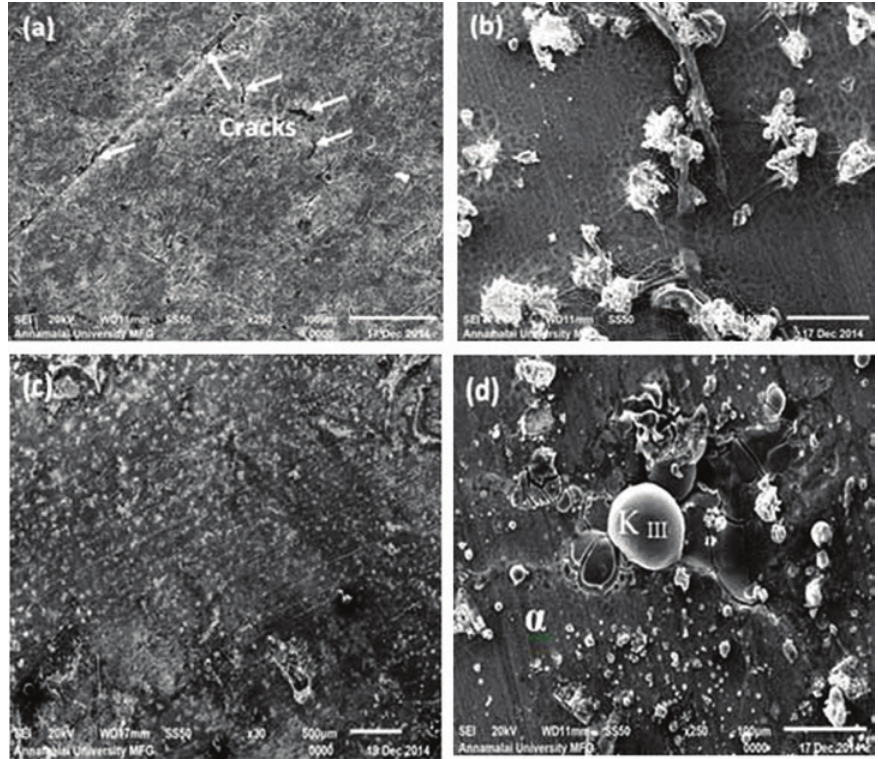
Figure 8: Effect of impact angle on erosion-corrosion